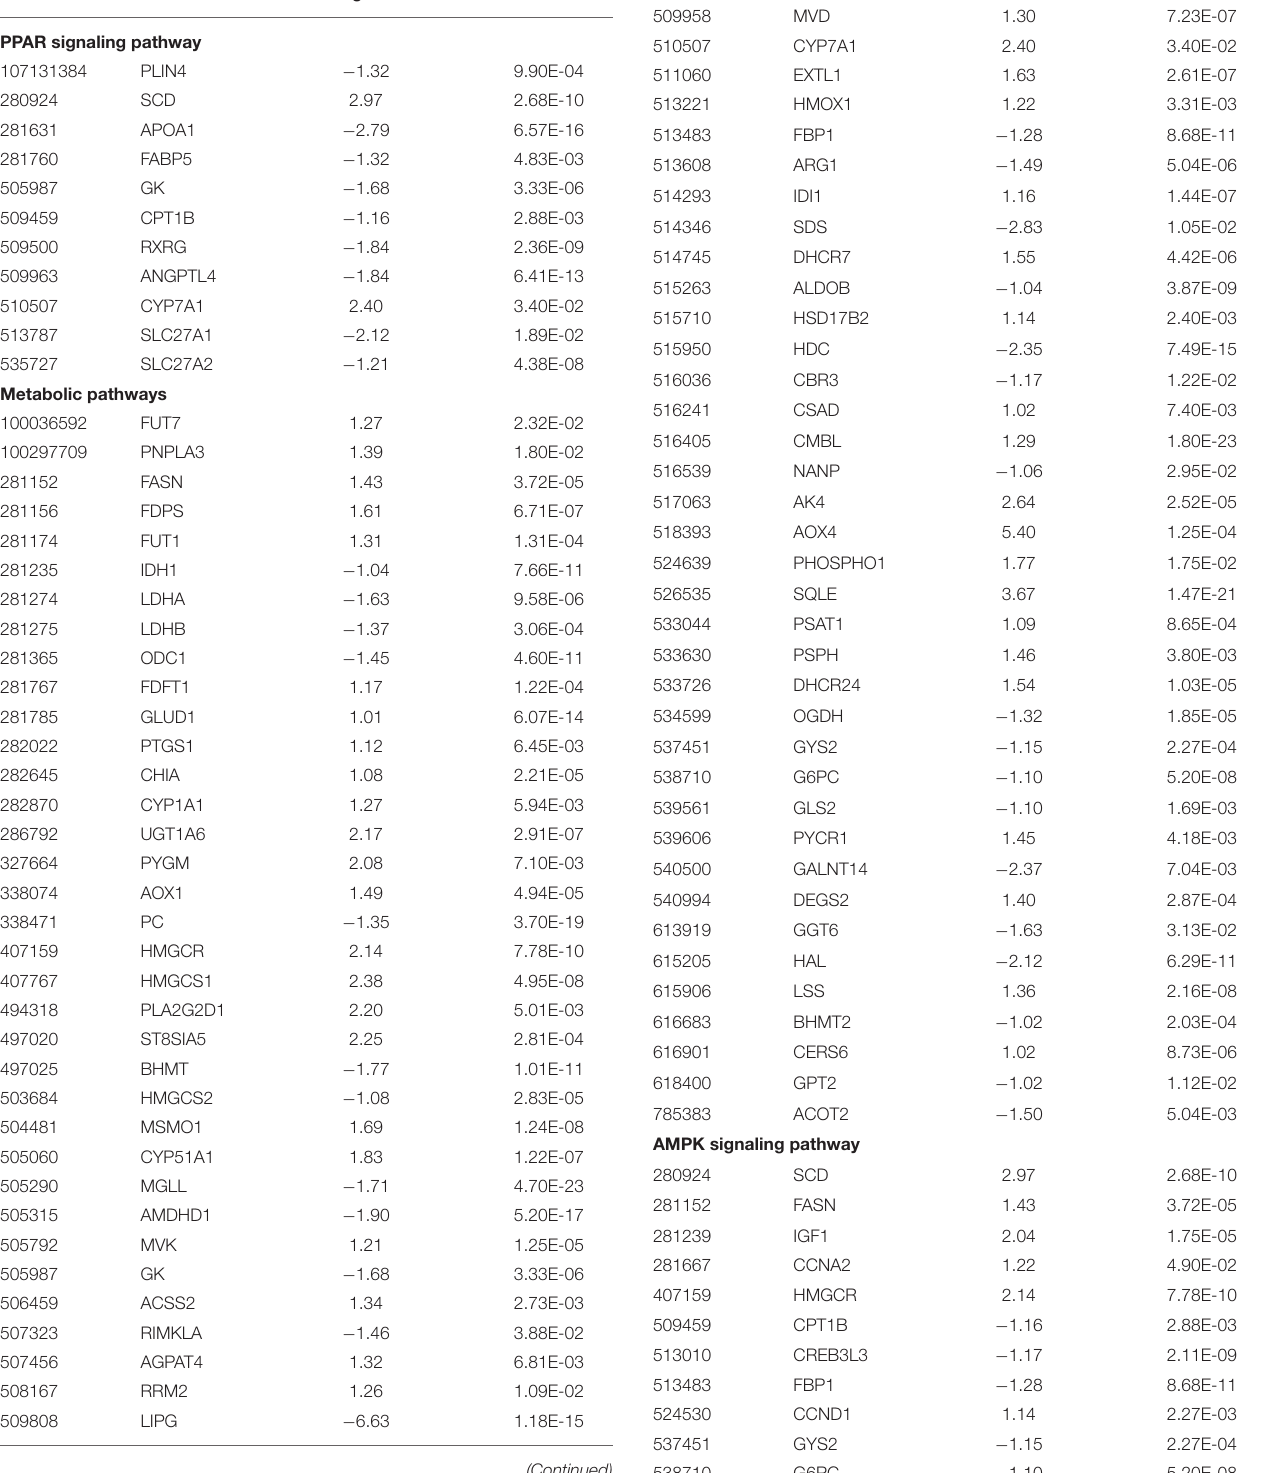
TABLE 6 | DEGs included in the PPAR signaling pathway, metabolic pathways, and AMPK signaling